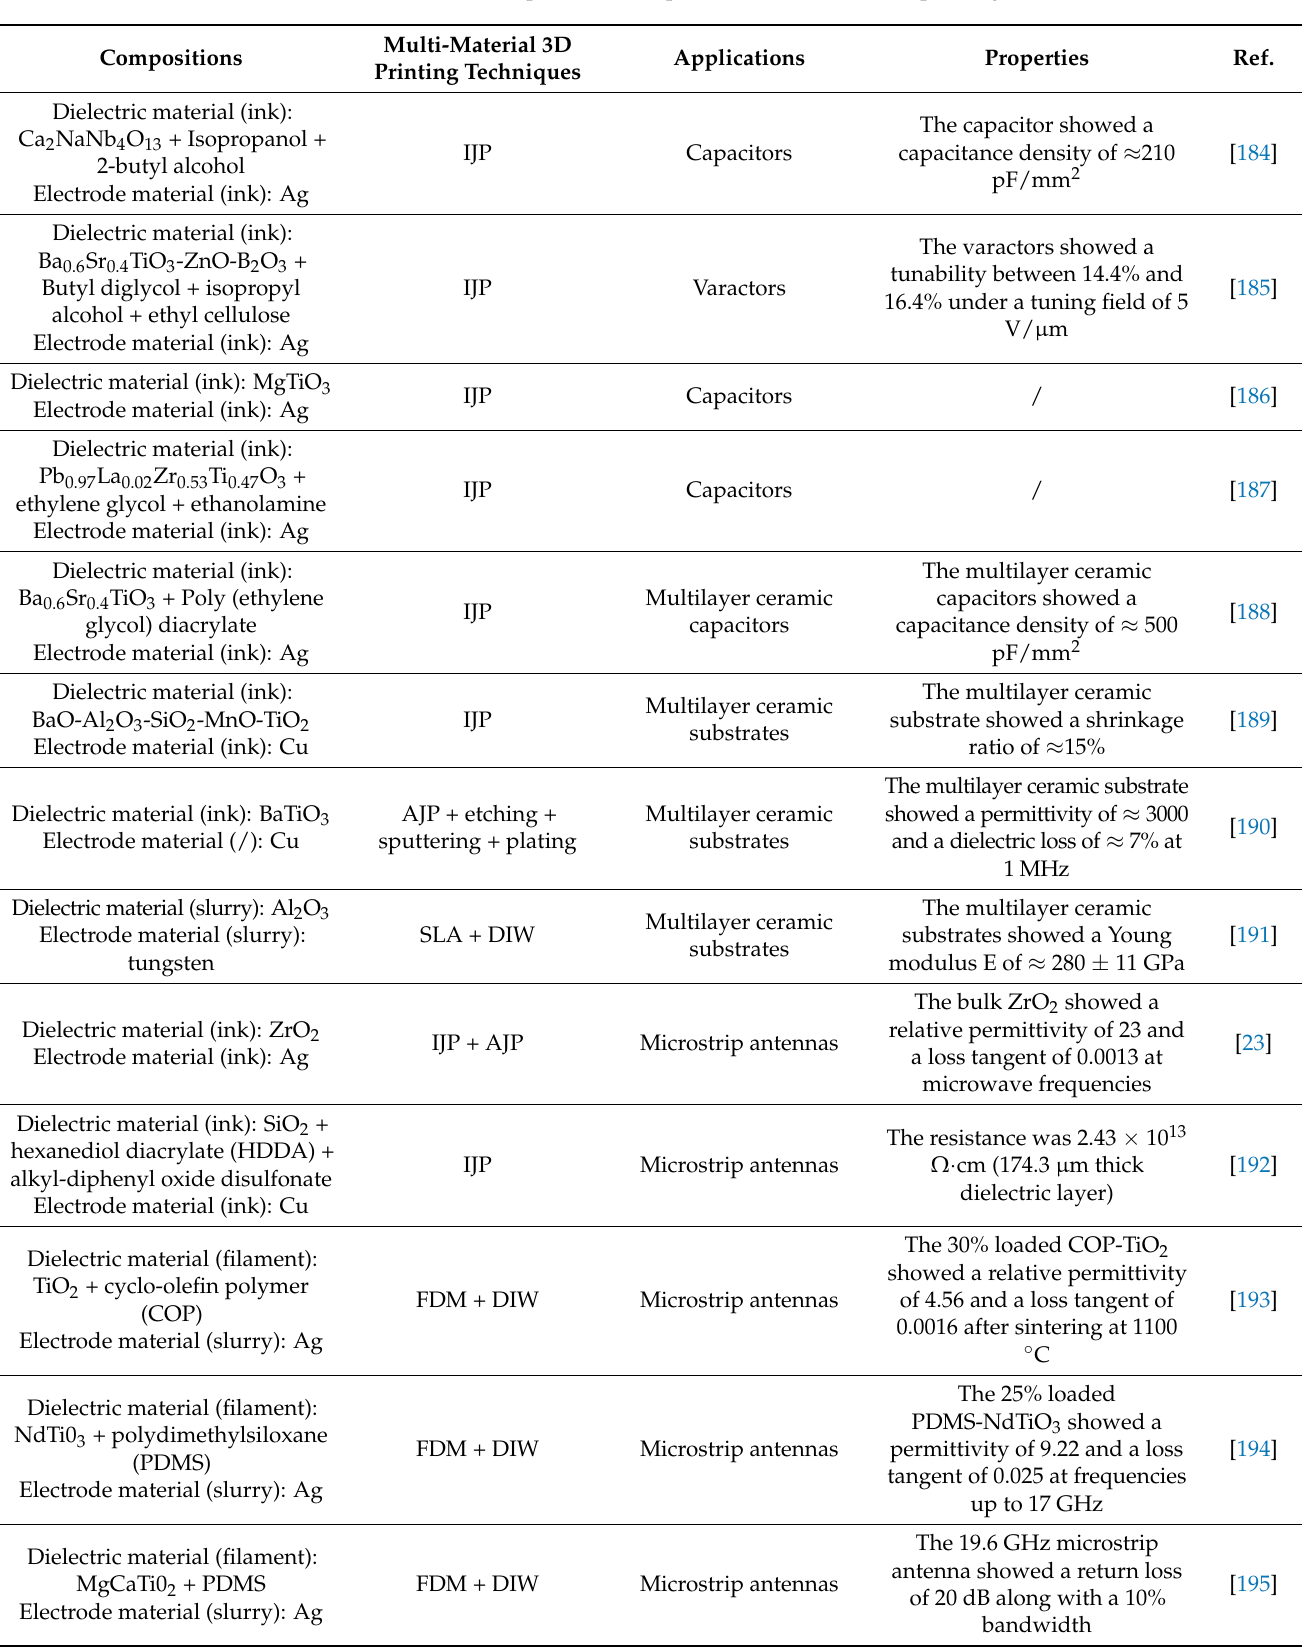
Table 2. Several composition examples of multi-material 3D printing in functional ceramic